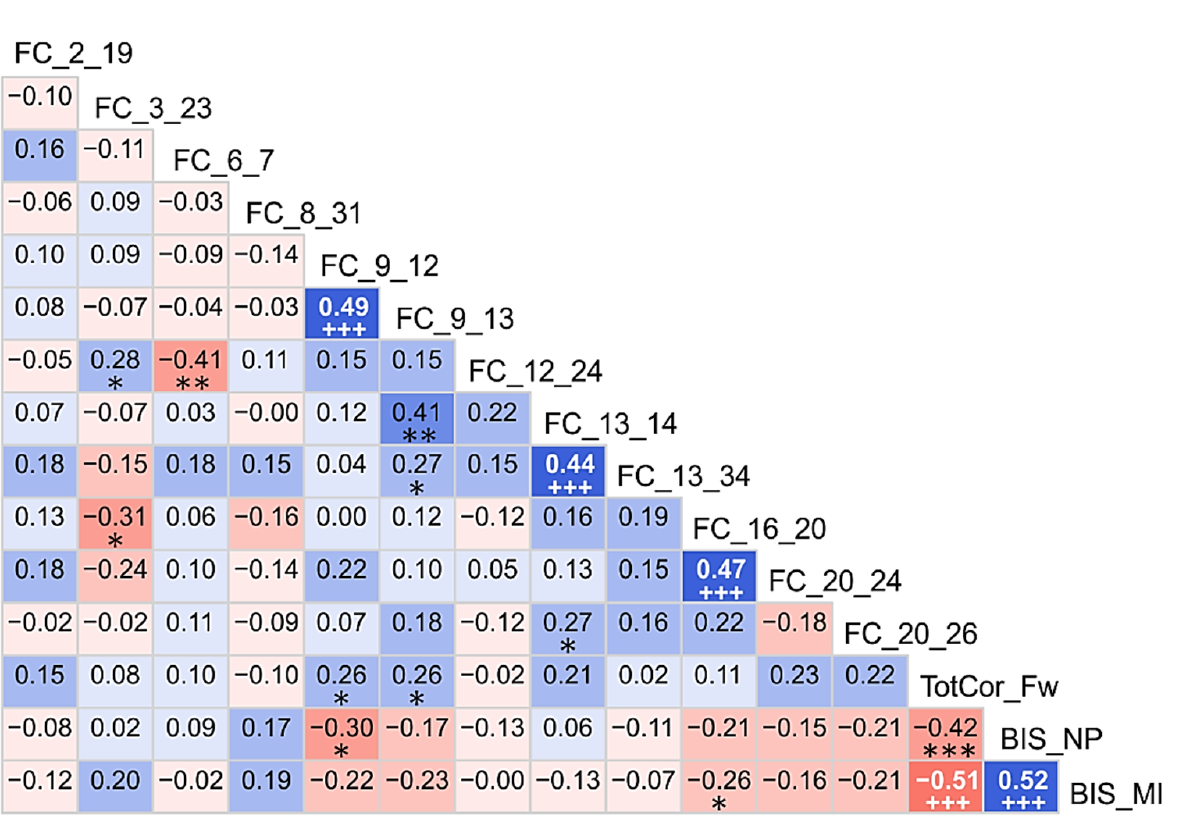
Table 4. Pearson bivariate correlations between the age of the participant and the top significant variables of the RF model. Correlation coefficient (r) and p -values (before Bonferroni correction) are provided for alcohol use disorder (AUD), control (CTL) group, and the total sample (ALL). None of the variables survived Bonferroni correction for multiple comparisons. Zero-order correlations were used for each group separately (N = 30) and partial correlations controlling for group effects were used for the all sample (N = 60). Feature